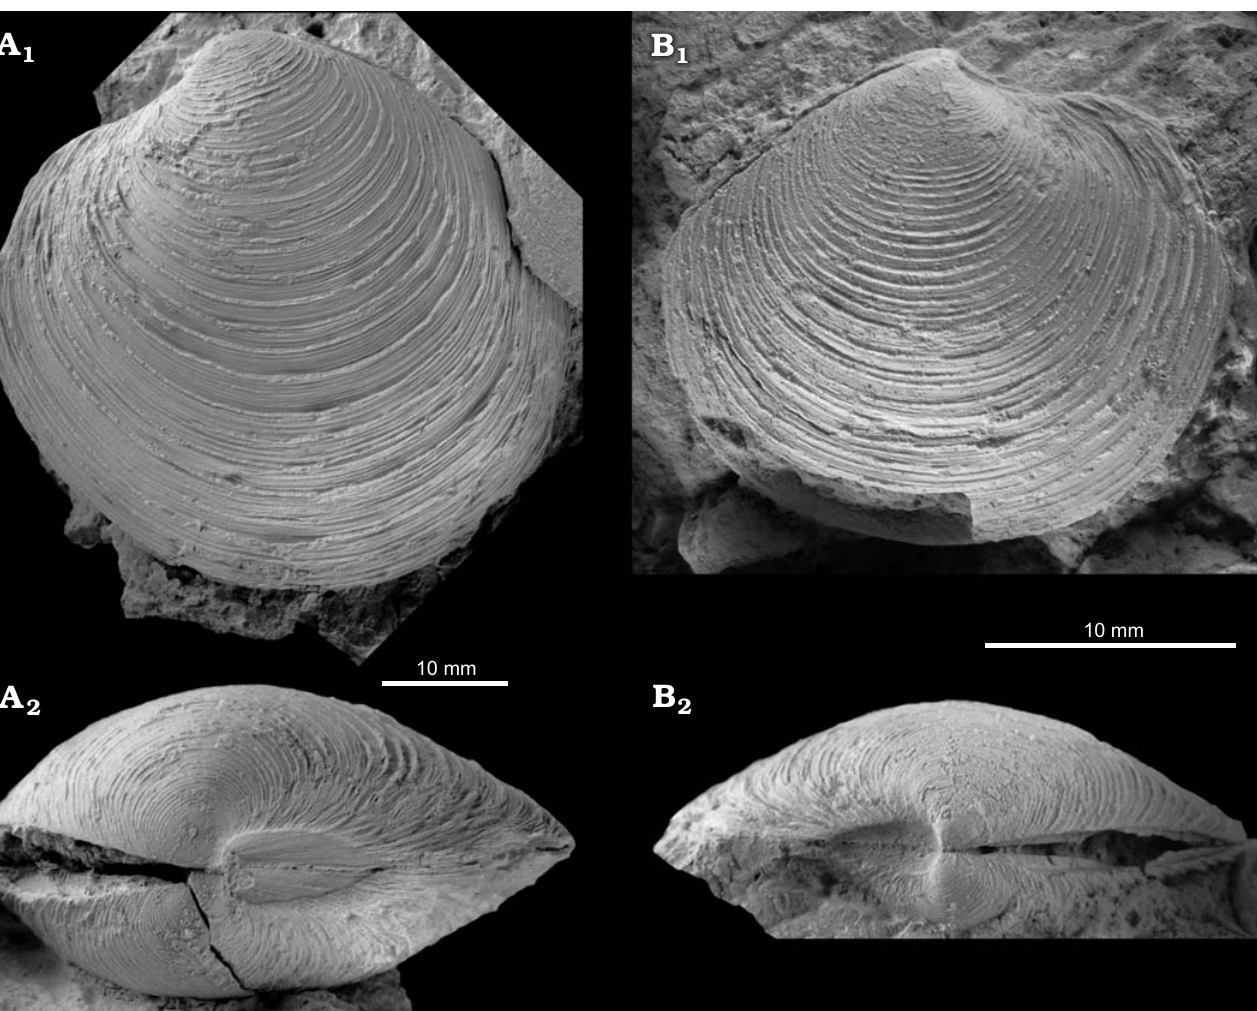
Fig. 7. The lucinid bivalve Lucinoma persolida (Sacco, 1901) from the late Pliocene of Italy, Stirone River seep deposit. A . MGGC.22015, small articu- lated specimen, view of right valve (A 1 ), dorsal view (A 2 ). B . NRM Mo184004, articulated specimen, view of left valve (B 1 ), dorsal view (B 2